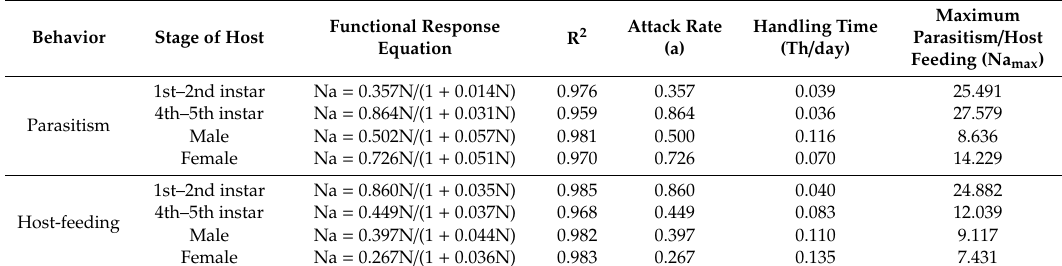
Figure 5. Functional response curves for Gonatopus flavifemur parasitism and host feeding at different stages of BPH (Holling type II). ( A ) Parasitism functional response curves. ( B ) Host-feeding functional response curves. Table 2. Functional response and parameters of Gonatopus flavifemur parasitism and host feeding at different BPH stages (Holling type II).